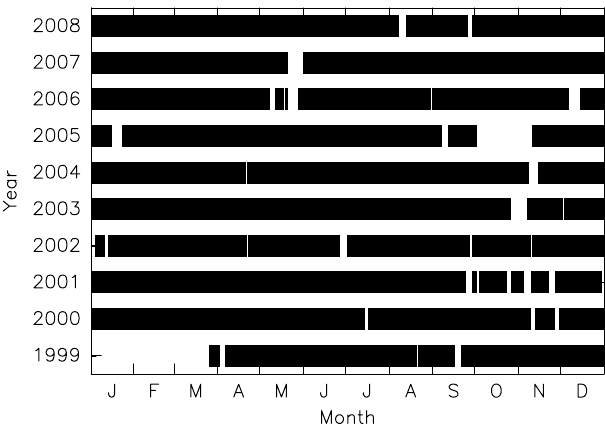
Fig. 1. Coverage of MF radar data recorded at Syowa and used in this